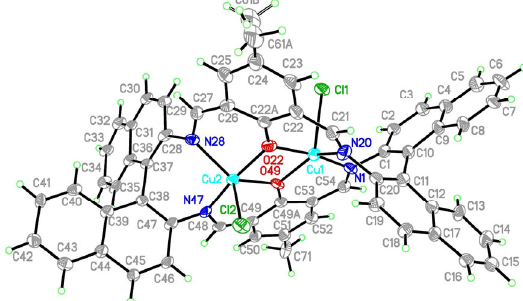
Figure 2. Structure of [Cu 2 Cl 2 (L’)] K1 with a numbering scheme and thermal ellipsoids at 30% probability.